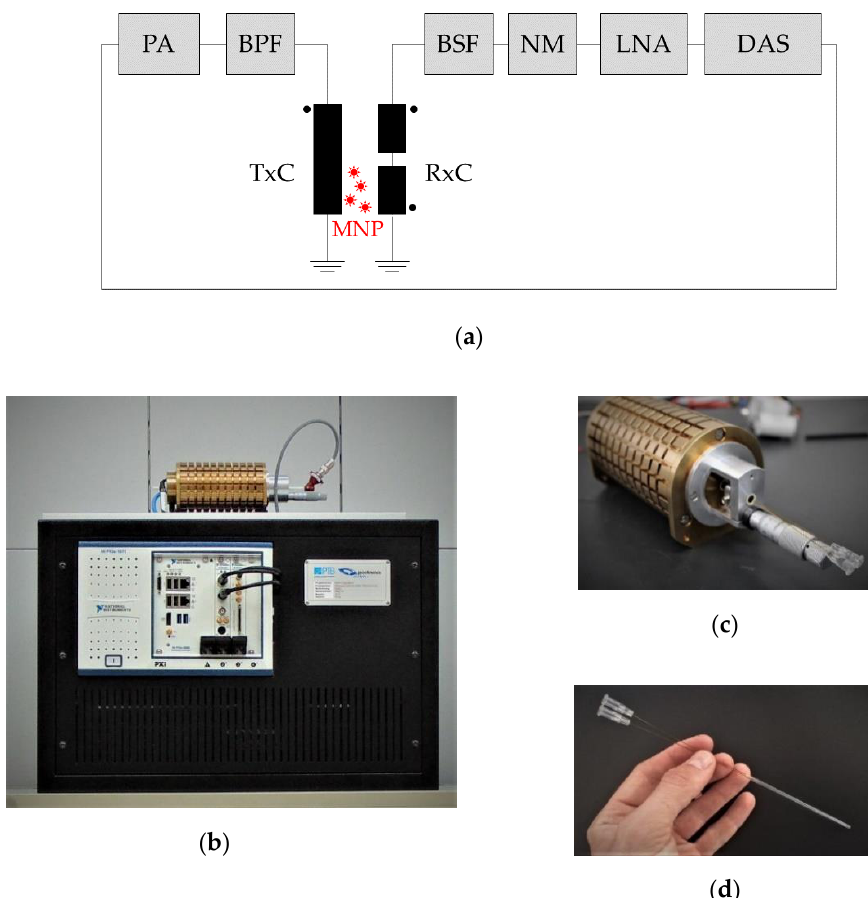
Figure 1. Benchtop magnetic particle spectroscopy (MPS) device: ( a ) Schematic signal chain of the benchtop MPS device consisting of a power amplifier (PA), a band-pass filter (BPF), and a transmit coil (TxC) on the excitation path. The receive path consists of a connectible band-stop filter (BSF), a noise matching transformer (NM), a low noise amplifier (LNA), and the data acquisition system (DAS). ( b ) Complete MPS device with computer-controlled data acquisition system (white chassis) and coil housing (top) without protective shielding. ( c ) Receive and transmit coil housing with inserted flow cell. ( d ) Capillary flow cell with theta-cross-section and polyimide-reinforced glass capillary inlet and outlet equipped with Luer-Lock connections.